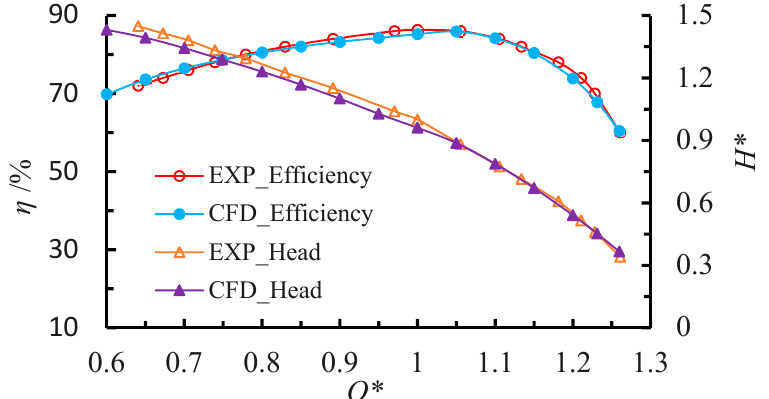
Figure 2. Performance curves for the baseline model.